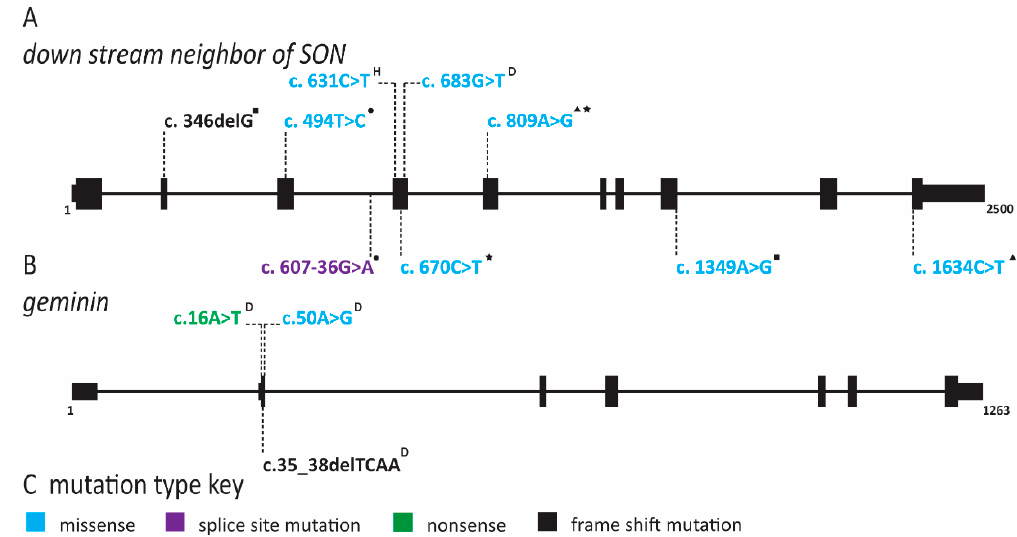
Figure 5. Mutations in downstream neighbor of son ( DONSON ) and geminin ( GMNN ) cause Meier-Gorlin syndrome. Exon and intron schematic was generated with the UCSD genome browser. Reference sequences are DONSON NM_017613.4 and GMNN NM_015895.5. Schematic of ( A ) DONSON and ( B ) GMNN genes depicted with exons as black boxes and introns as horizontal lines. Mutations are mapped to the appropriate gene regions. “H” superscript indicates a homozygous mutation. “D” superscript indicates a heterozygous dominant mutation. Compound heterozygous mutation pairs are indicated by superscript symbols. Each mutation combination is depicted, and certain alleles may be present in multiple combinations. The frequency of each allele in the affected population is not indicated. ( C ) For each gene, the color of the mutations indicates the type of mutation according to this key.